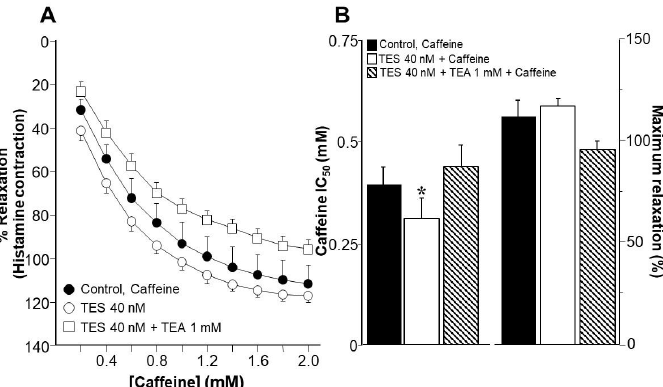
Figure 1. Chronic incubation with testosterone (TES) potentiates caffeine-induced guinea pig tracheal smooth muscle relaxation, whereas acute (10 min) administration of tetraethylammonium (TEA) suppresses this androgen’s action. ( A ) Cumulative caffeine concentration-response curve showing relaxation of tracheal rings precontracted with histamine (10 µ M). Tissue incubation with TES (40 nM, n = 6) for 48 h induced a significant leftward shift of the concentration-response curve to caffeine. In contrast, administration of the non-selective K + channel blocker TEA (1 mM) 10 min before stimulation with caffeine shifted the curve to the right. ( B ) The bar graphs summarize that TES 40 nM significantly reduced the caffeine inhibitory concentration by 50% (IC 50 , right panel) compared with the control group. The maximum response (left panel) to caffeine did not differ when TES or TES + TEA were tested. Symbols and bars represent mean ± S.E.M., * p < 0.05. Repeated measure analyses of variance were performed, followed by Dunnett’s multiple comparison tests.